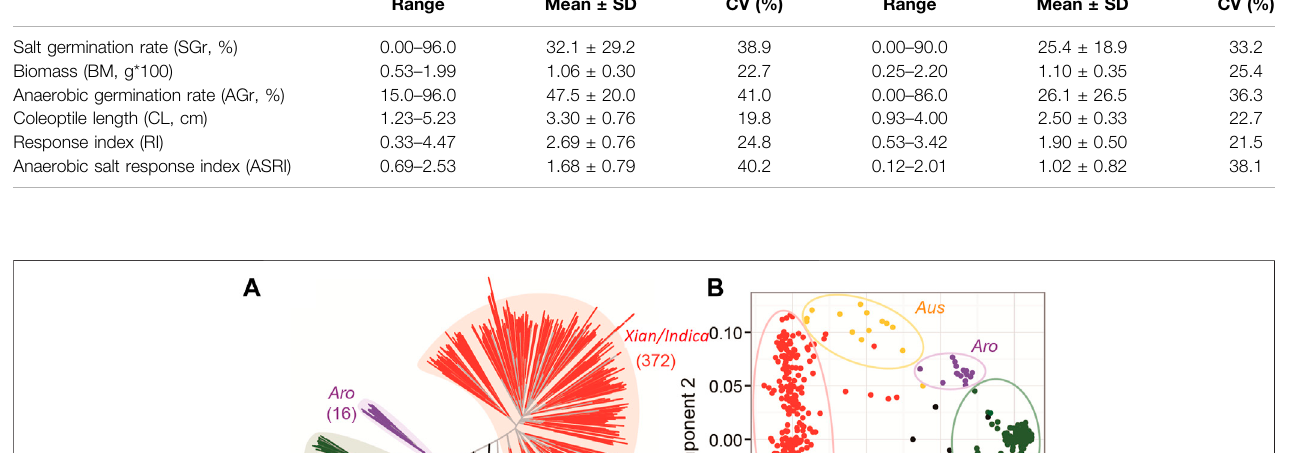
Frontiers in Genetics |